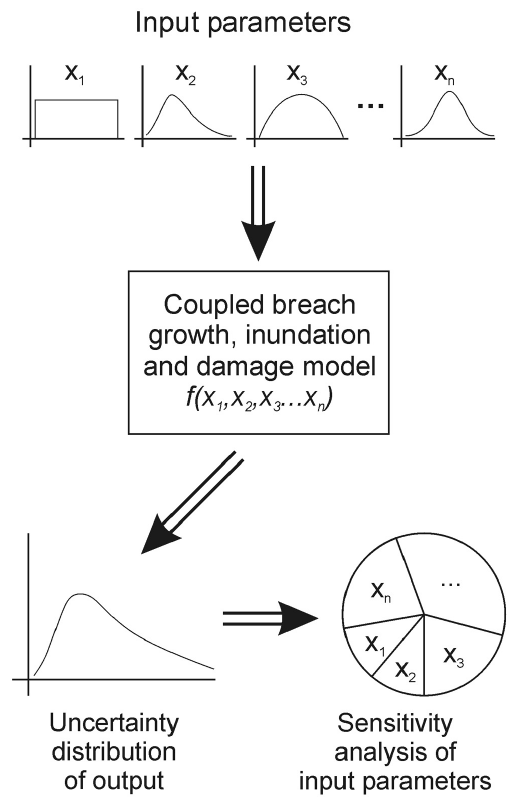
Fig. 5. Schematic representation of uncertainty and sensitivity anal- ysis (after Crosetto et al.,